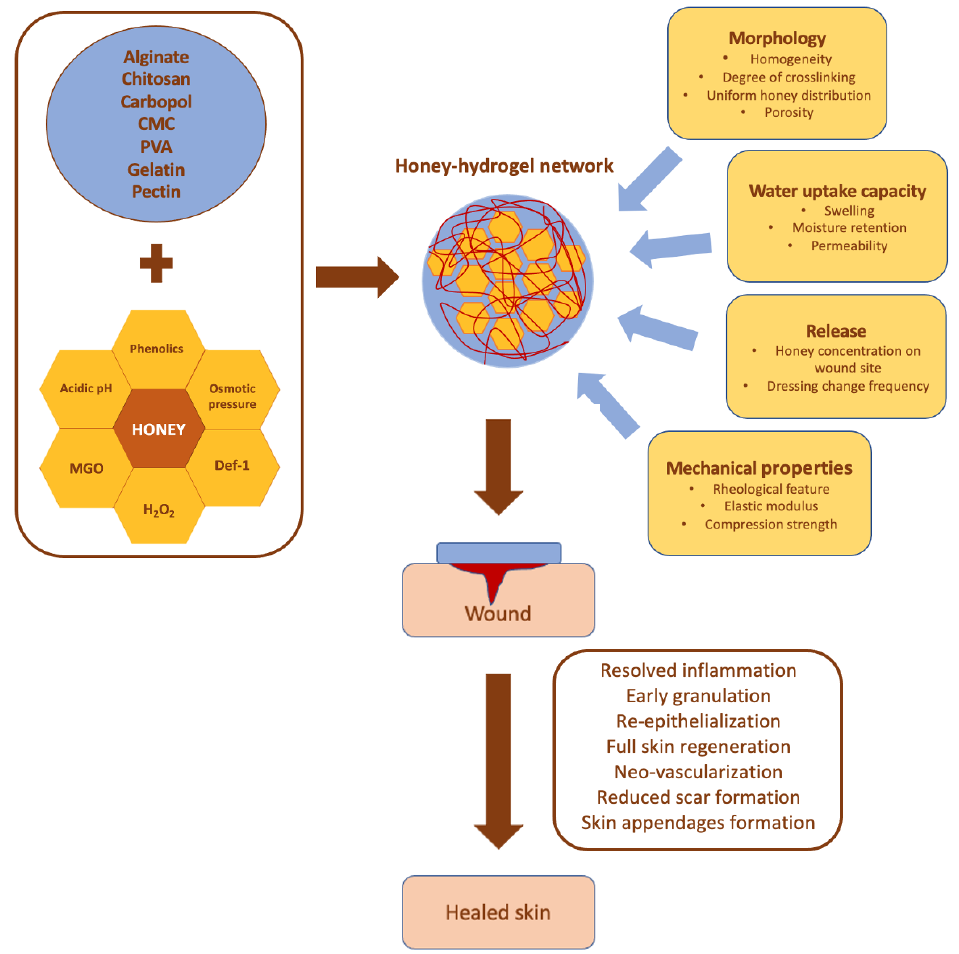
Figure 2. Schematic representation illustrating critical aspects for the optimisation and charac- terisation of a honey-loaded scaffold for wound repair, with examples of polymers successfully demonstrated in published literature, as discussed in Section